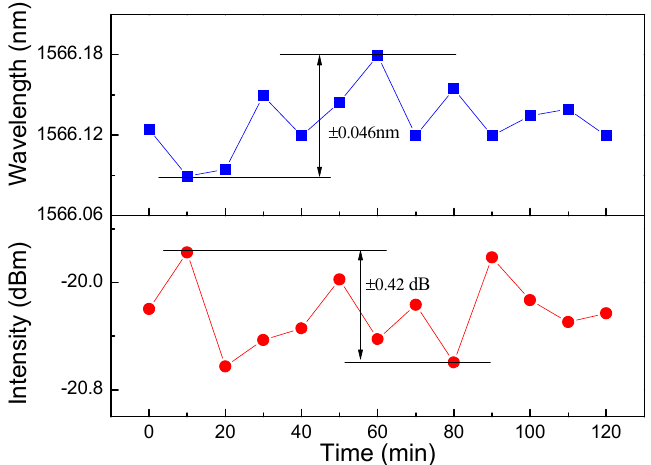
Figure 11. The stability of laser wavelengths within 2 hours.